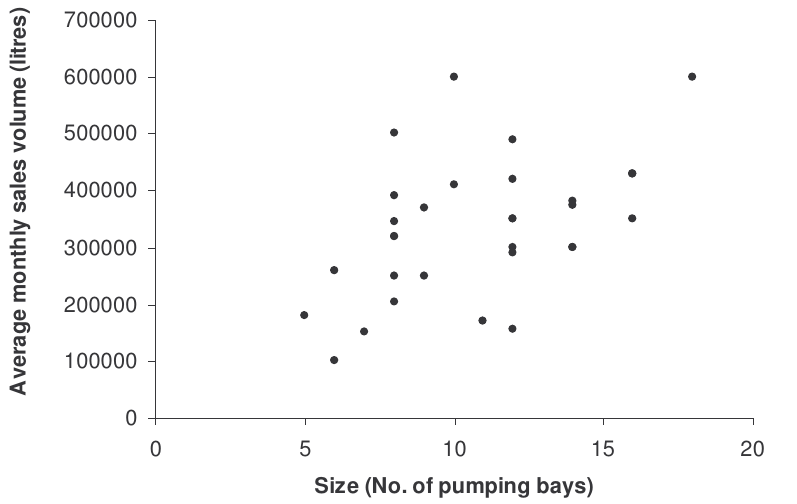
Figure 3: Size versus average monthly sales